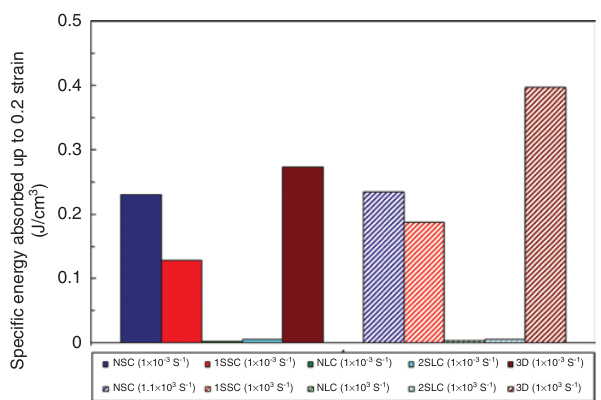
Figure 10 Comparison of specific energy absorption between quasi-static and high strain rate tests on various Al